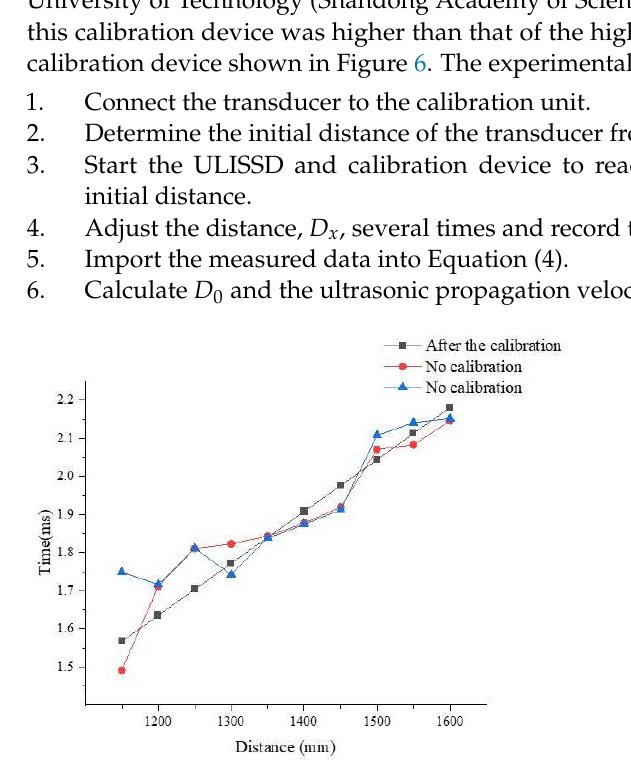
Figure 11. Comparison of data of transducer No. 1 before and after calibration.